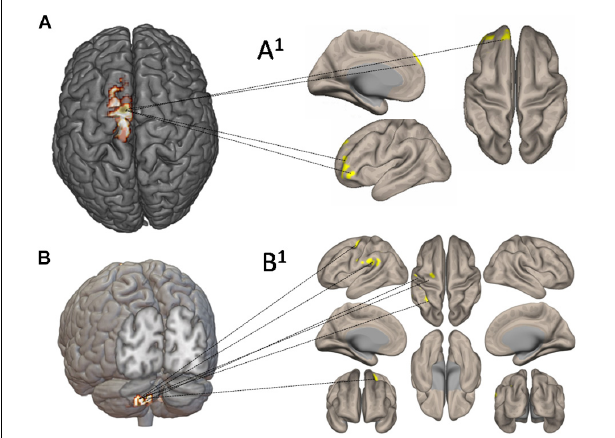
FIGURE 7 | Functional connectivity and cerebral blood flow (CBF) changes by using seed-to-voxel analysis. In (A) , increased CBF areas in the left supplementary motor area and primary motor cortex have been used as seed: the functional connectivity is demonstrated with frontal lobe (area 10) (A1) . In (B) , increased CBF areas in left crus II have been used as seed: the functional connectivity has been demonstrated with the left prerolandic and post-rolandic areas and the left supramarginal area (B1)